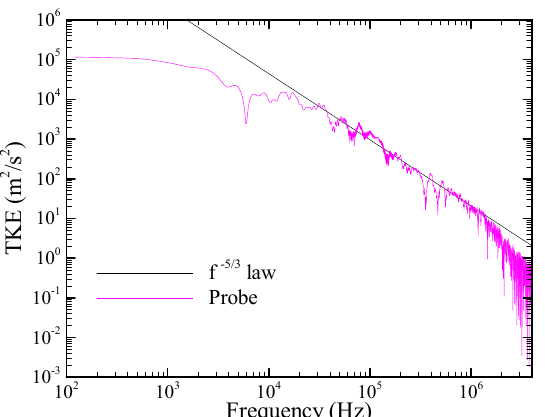
Figure 3. Comparison of the frequency spectrum of TKE with Kolmogorov’s − 5/3 law.